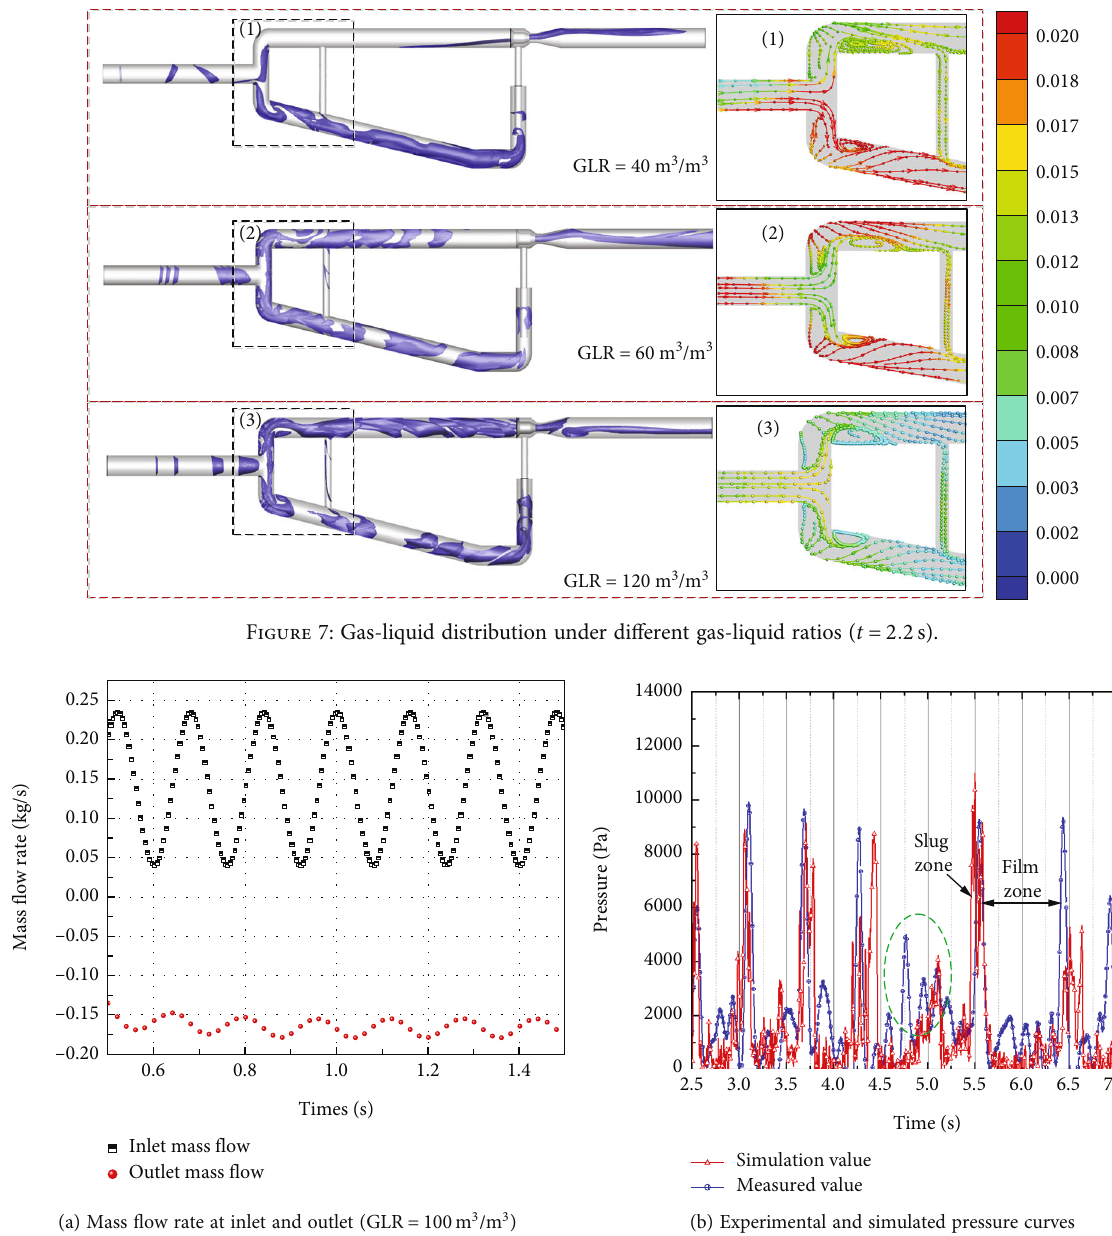
Figure 8: Variation of fl ow and pressure at the inlet and